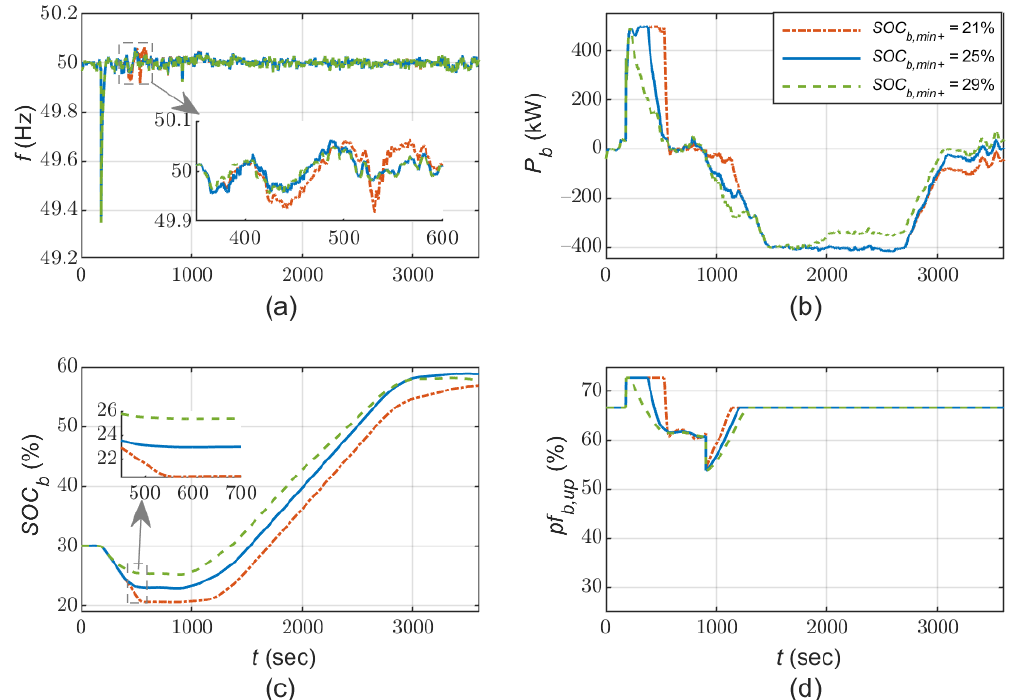
Figure 12. Response following a diesel unit outage at 150 s and synchronization of another at 900 s, for different SOC activation zones. ( a ) Frequency, ( b ) BESS active output power (positive: injection, negative: absorption), ( c ) SOC, ( d ) BESS aFRR-up participation factor.